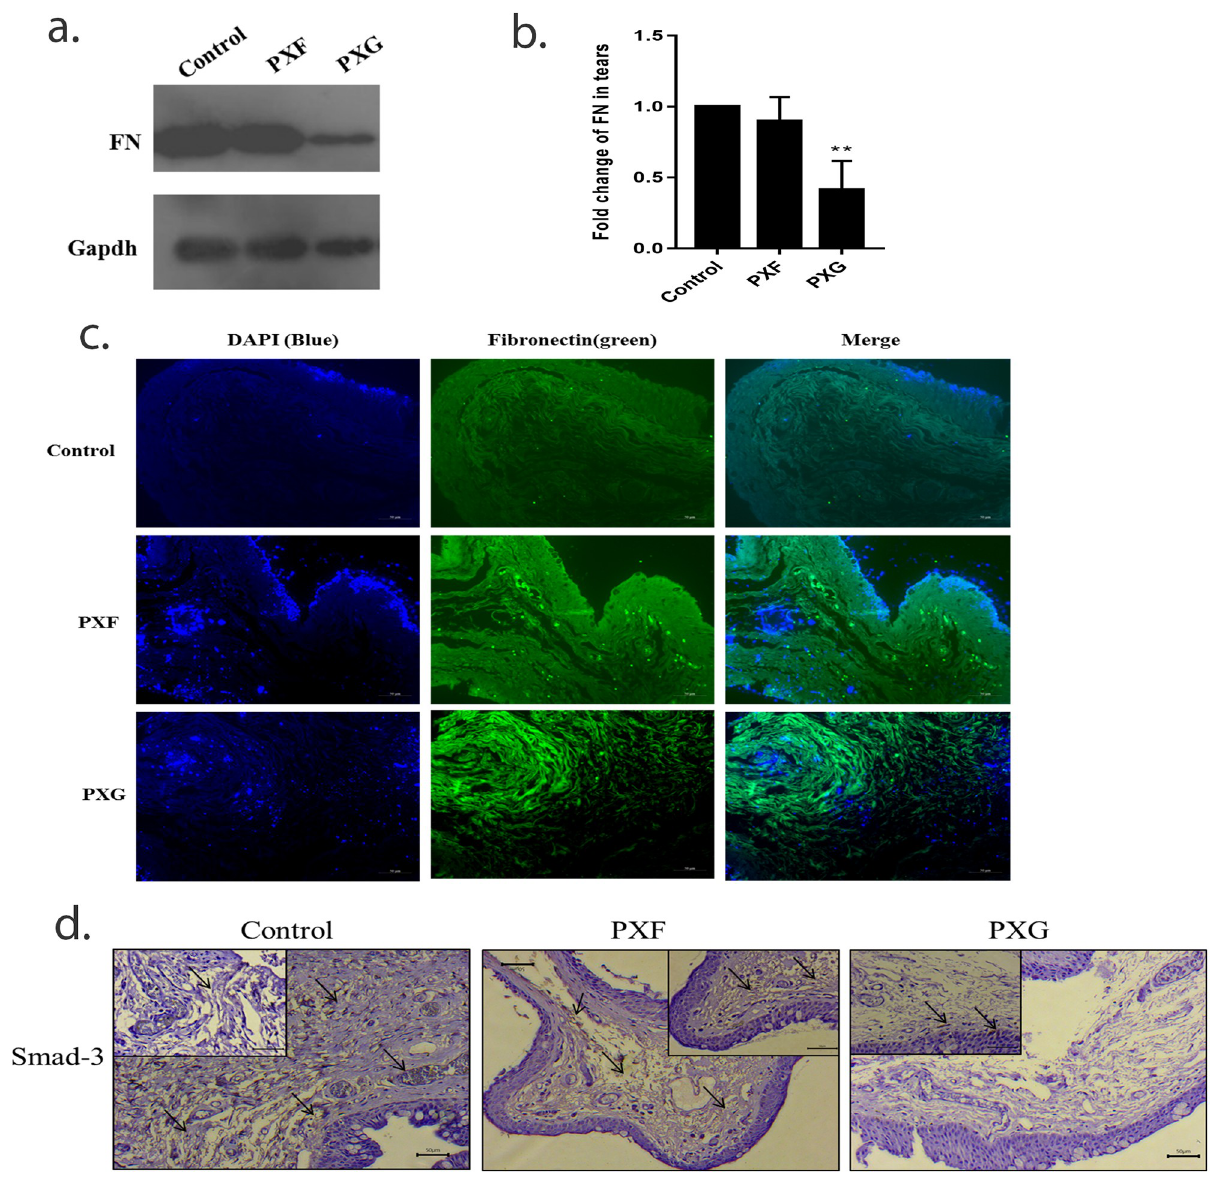
Fig 4. Evaluation of FN1 in ocular tissue. a and b, protein level of FN1 in tears (n = 3) using western; c, immunofluorescent images of FN1 in tenons capsule (n = 5) at × 20 magnification; d, bright field microscopic images at × 20 and × 40 (inset) magnifications of SMAD-3 in tenons capsule (n = 3) using imunohistochemical study. Scale bar-10um, Means ± STDEV shown, �� p < 0.01, one way ANOVA post hoc t test with Turkey correction, PXF- pseudoexfoliation, PXG- pseudoexfoliation